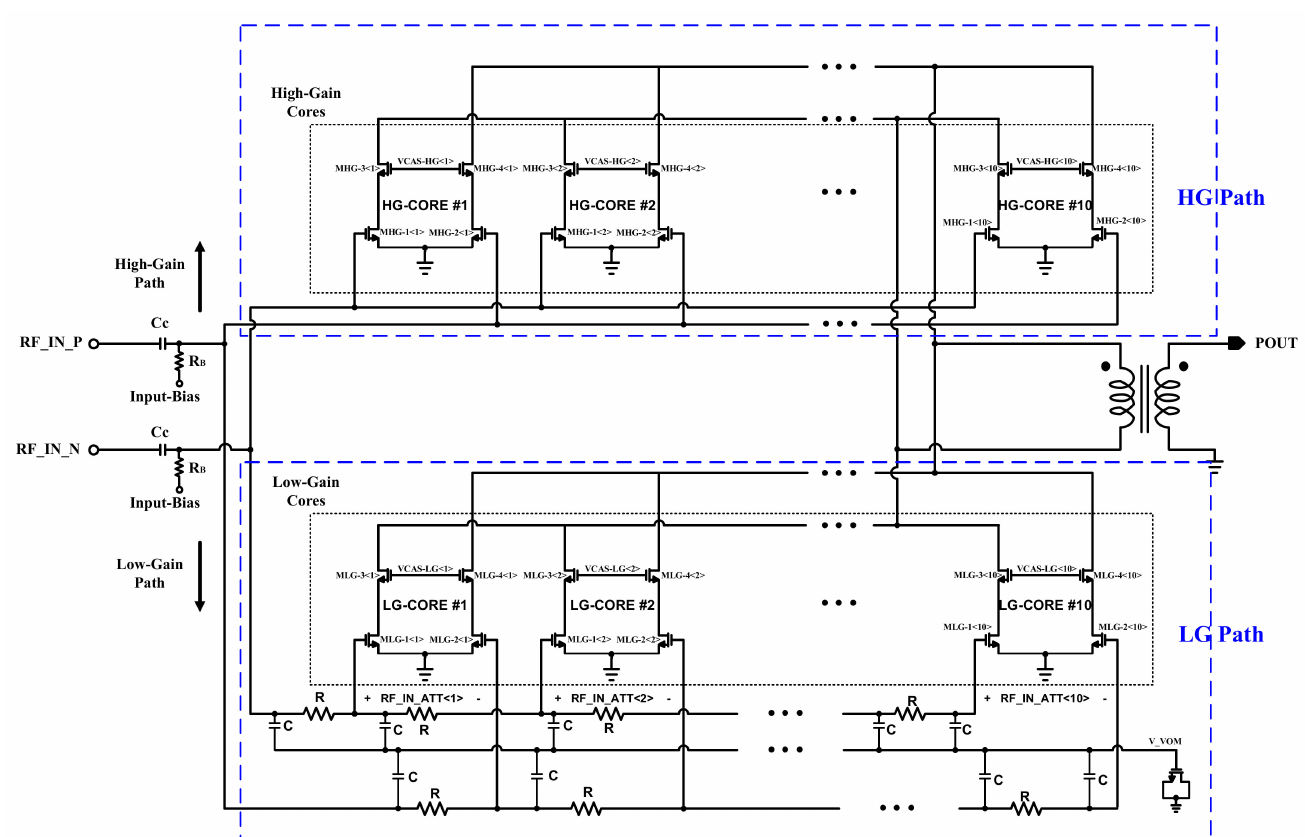
Figure 4. The top schematic of the proposed power combining DPA structure in a dual path of power amplification and attenuation implementation.